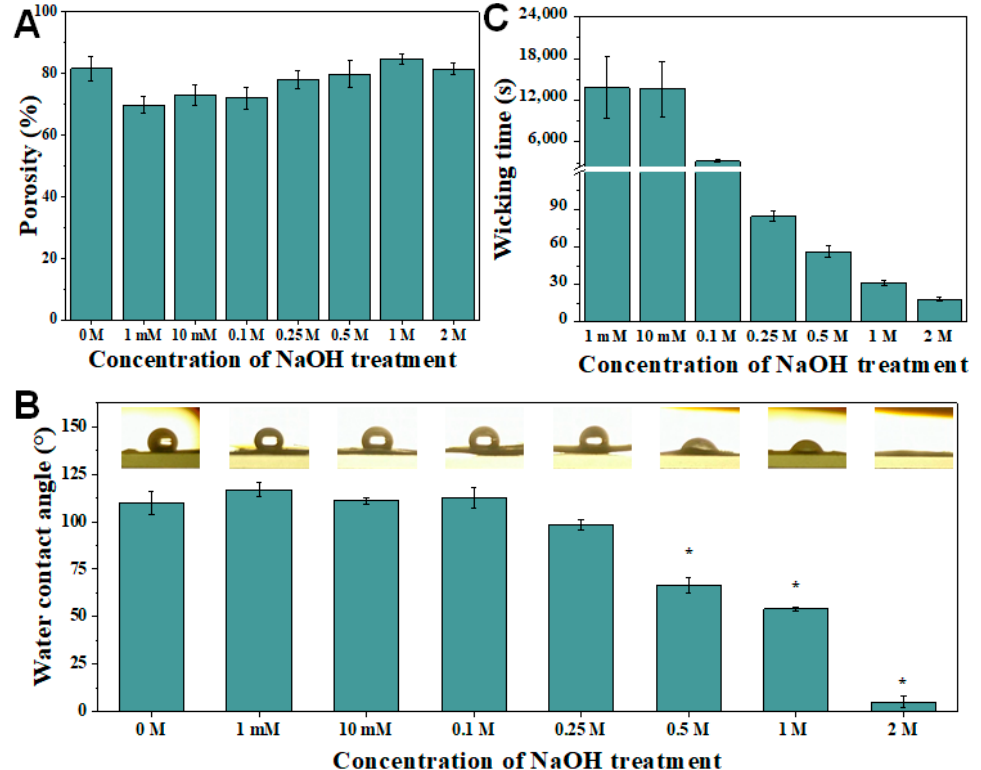
Figure 4. The influence of NaOH concentration upon wetting and wicking parameters. The porosity ( A ) of the post ‐ treated nanofibers was not significantly affected by the NaOH concentration. The water contact angle shows a significant reduction at NaOH concentration lower than 0.25 M ( B ); The wicking time of liquid from sample pad to test line of NaOH ‐ treated electrospun PCL nanofibers substantially reduced as the NaOH concentration increased at 0.25 M ( C ). n = 4 for each concentration in ( A , B ), and n = 3 for each concentration in ( C ). * represents p < 0.05.